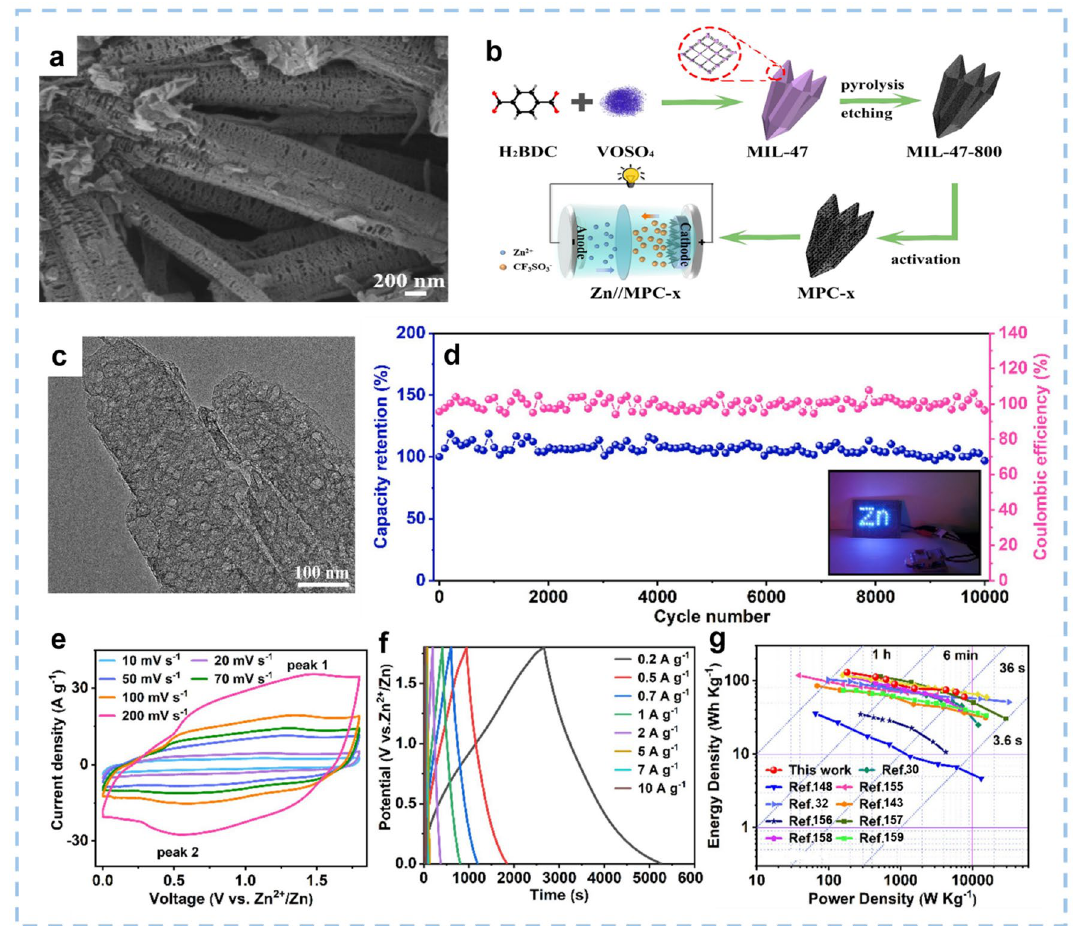
Fig. 12 The preparation process, morphology, and structure of the MPC-2 and the electrochemical performance of Zn//MPC-2 ZIHC device. a , c SEM image and TEM image of the MPC-2. b Schematic illustration for the preparation of MPC and construction of the Zn//MPC-x ZIHC. d Cycling performance and Coulombic efficiency at 10 A g −1 (inset showed LED array powered by the ZIHC). e CV curves at different scan rates ranging from 10 to 200 mV s −1 . f GCD curves at various current densities ranging from 0.2 to 10 A g −1 . g Ragone plots compared with other ZIHC devices. Reproduced with permission [30, 32, 103, 154, 174, 179, 184–187]. Copyright 2022,